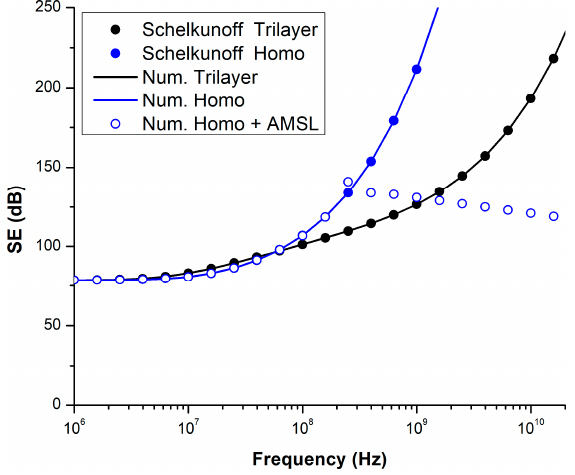
Figure 10. Shielding effectiveness of the trilayer composite (black dot) and the homogenized layer (blue dot) obtained with Schelkunoff decomposition, and the trilayer composite (black line), the homogenized layer (blue line), and the artificial layer (blue/white dot) obtained in far ‐ field with the numerical model.